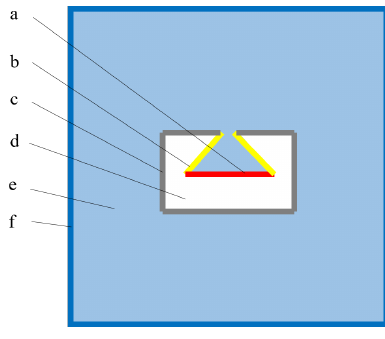
Figure 9. Section view of boundary conditions: ( a ) Isothermal copper wall at cavity temperature, conductivity = 387.6 W/m · K; ( b ) isothermal steel wall at cavity temperature, conductivity = 16.27 W/m · K; ( c ) isothermal wall at 300K, conductivity = 0; ( d ) hollow (excluded from calculation); ( e ) incompressible ideal air, density = 1.225 kg/m 3 , conductivity = 0.0242 W/m · K; ( f ) pressure inlet, constant gauge pressure = 0, temp = 300